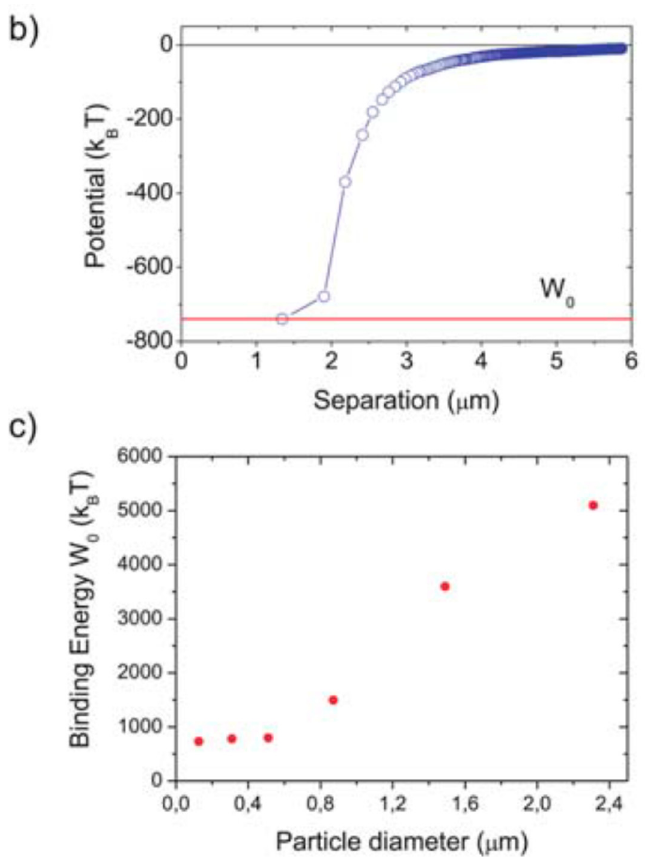
Figure 3. ( a ) Two dipolar nanoparticles of 125 nm in diameter are attracted along the nematic director into the dipolar pair. ( b ) The separation dependence of the attractive potential and the minimum of the attractive potential representing the binding energy W 0 . ( c ) The measured binding energy of two dipolar particles is decreased by reducing the size of the particles, but is approximately constant below 500 nm. Reproduced with permission from Ref. [78]. (Copyright 2010, Royal Society of Chemistry).